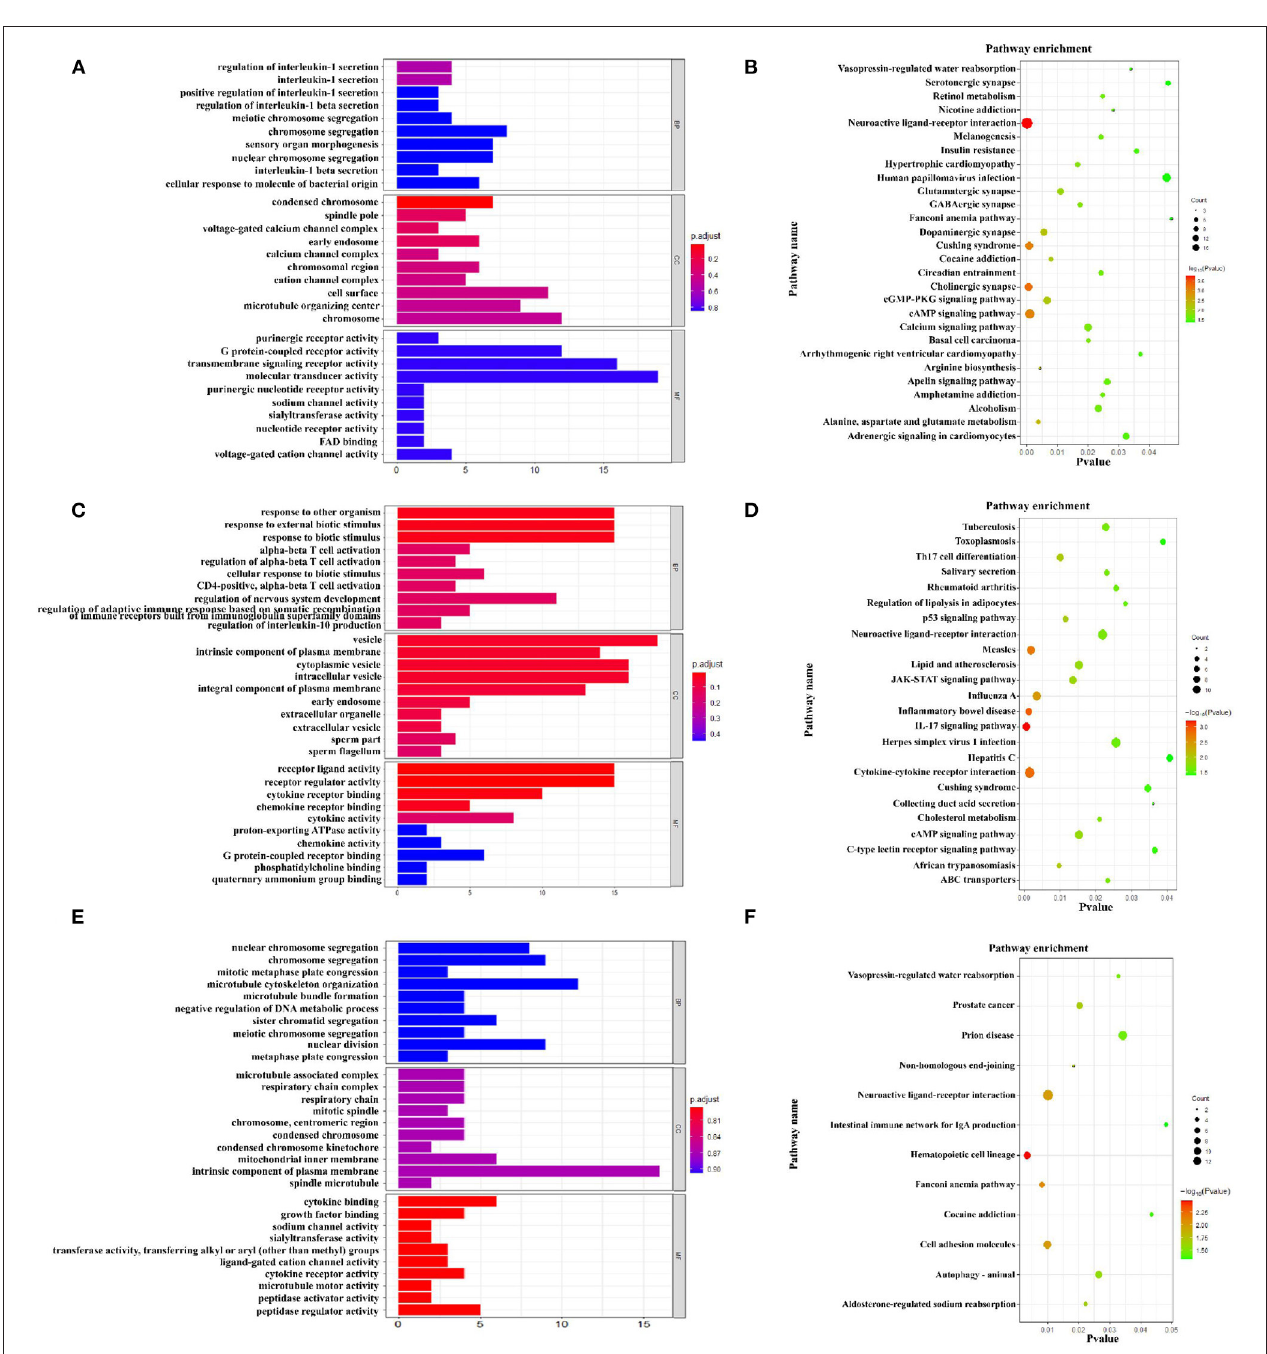
FIGURE 5 | Function analysis of different expression genes (DEGs) in ileum mucosa between two treatment groups based on Gene Ontology and KEGG pathway. (A) Enriched GO terms of DEGs between M3 and M1 groups; (B) KEGG enrichment analysis of DEGs between M3 and M1 groups; (C) Enriched GO terms of DEGs between M5 and M1 groups; (D) KEGG enrichment analysis of DEGs between M5 and M1 groups; (E) Enriched GO terms of DEGs between M5 and M3 groups; (F) KEGG enrichment analysis of DEGs between M5 and M3 groups. M1, one meal per day; M3, three meals per day; M5, five meals per day.